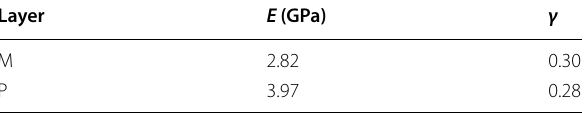
Table 2 Isotropic elastic constants for M and P